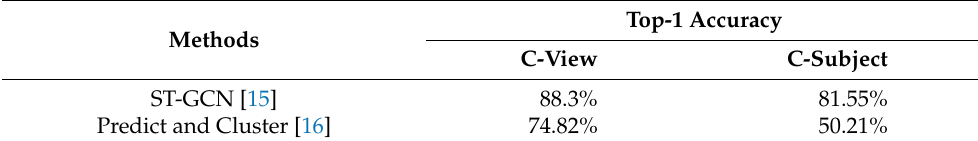
Table 1. Results of the state of the art methods on NTU-RGB+D.